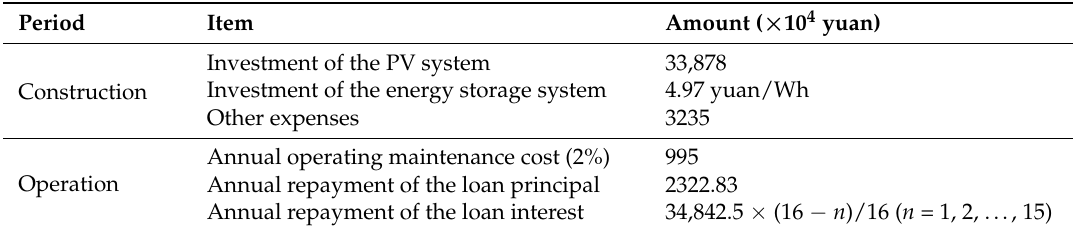
Table 6. The specific data on the construction and operation